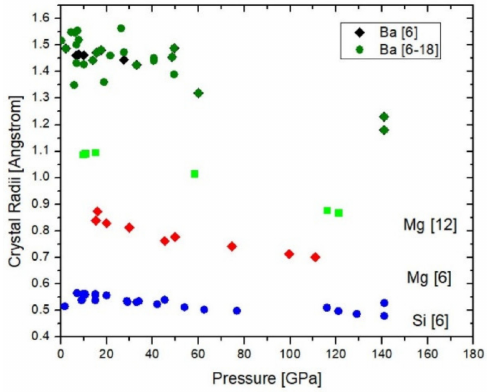
Figure 3. Crystal radii of Ba (black = coordination {6}, green: coordination {6} to {18}), Mg (green squares = coordination {12}, red diamonds = coordination {6}), and Si (blue) as function of